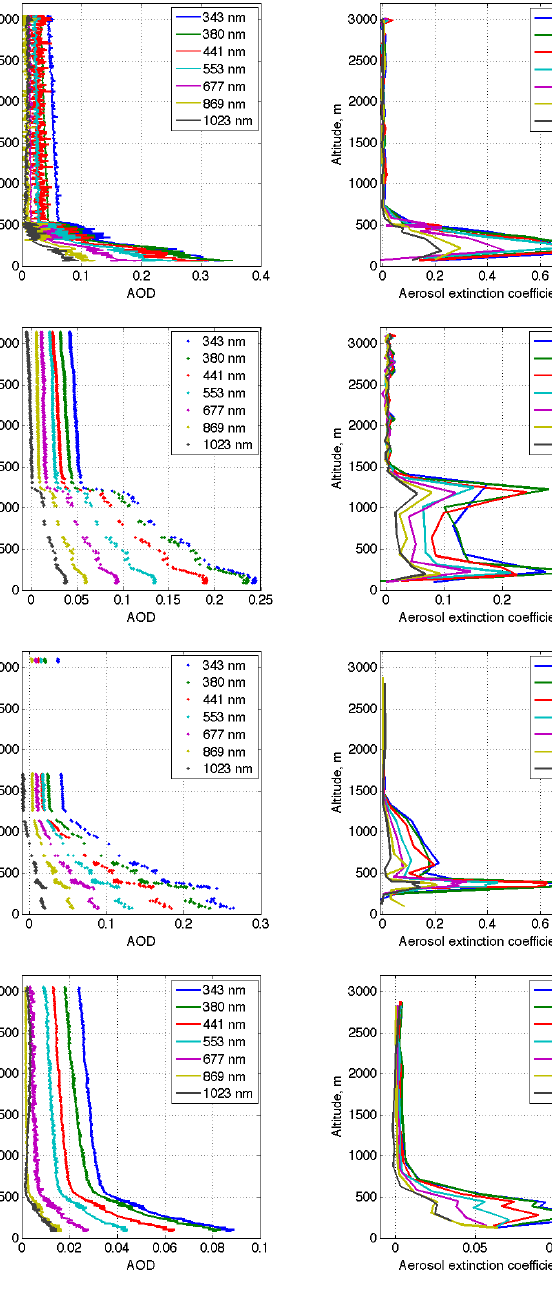
Figure 3: PLASMA AOD (left), aerosol extinction coefficient (center) at 7 channels and aerosol extinction coefficient compared with lidar (right) as a function of the altitude acquired near Lille region the 12th October 2010, 28th September, 29th September and 15th October 2011.